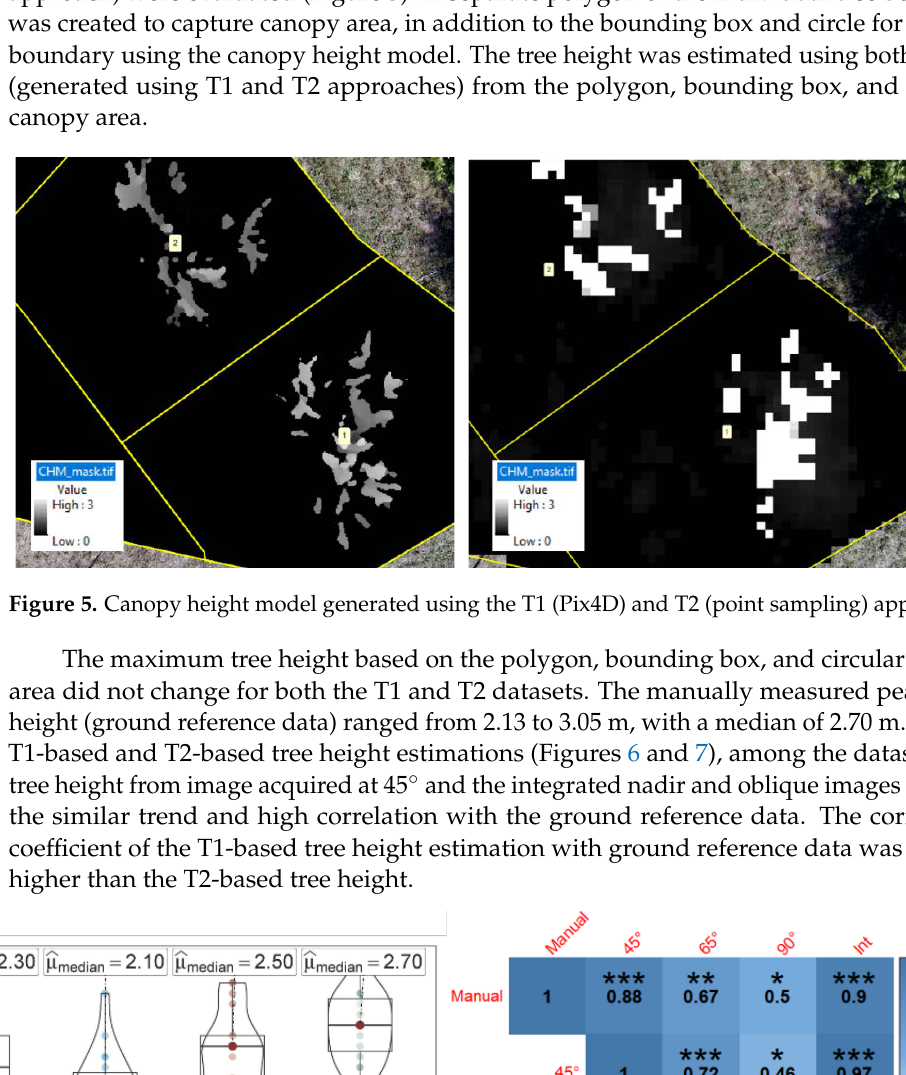
Figure 6. ( a ) Violin box plot showing the tree height range (m) and the ( b ) correlation matrix show- ing the correlation between the ground reference data and estimated T1-based tree height at indi- vidual angles (45°, 65°, and 90°) and the integration of nadir and oblique images. Significant proba- bility level: * 0.05, ** 0.01, and *** 0.001.